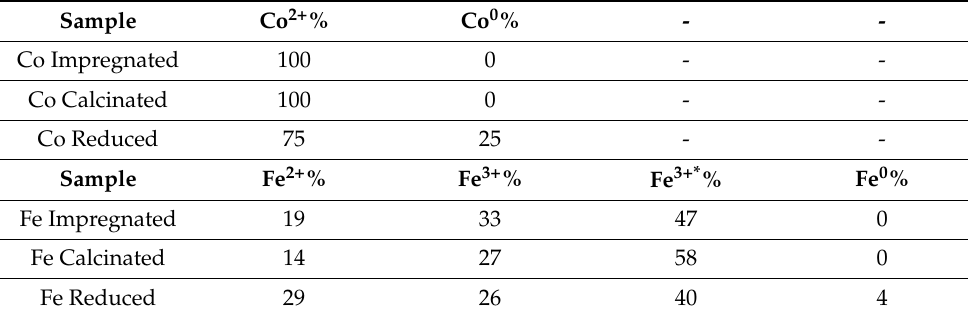
Table 3. Degree of metal reduction at different process